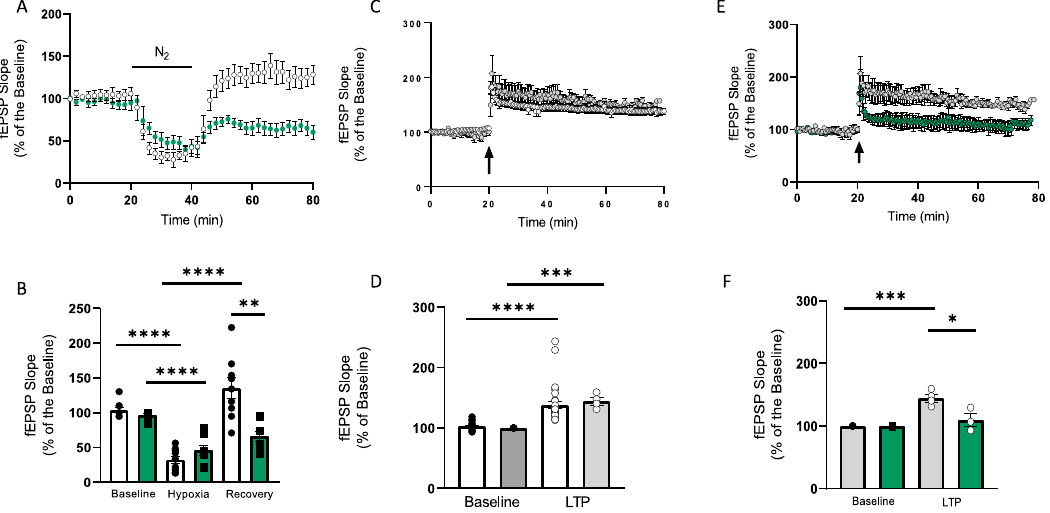
Figure 3. Application of MnTMPyP modulates synaptic transmission and plasticity post-hypoxia. ( A ) Time-course showing changes in CA1 fEPSP slope following a 20 min hypoxic episode for control (white circles) and MnTMPyP (2.5 µM, green circles). In the CA1, hypoxia gave rise to a maximum depression of fEPSP slope to 32.45 ± 6.8% and full recovery (135.41 ± 12%) upon reoxygenation ( n = 9). In slices pretreated with 2.5 µM MnTMPyP, the hypoxia-induced fEPSP slope depression was 45.8 ± 7.4% ( n = 8), with partial recovery upon reoxygenation (66.24 ± 8%; n = 8). ( B ) Bar chart summarising the time-course data in A. White bars represent controls, green bars represent MnTMPyP-treated group. ( C ) Time-course of fEPSP slope before and after HFS from control hippocampal slices (white circles) and from hippocampal slices exposed to 20 min hypoxia (grey circles). Time-course showing control LTP (white circles; n = 27) and LTP post-20 min hypoxia (grey circles; n = 4). HFS induced a stable LTP in control slices lasting 60 min (135.0 ± 6.1%, n = 27) with no di ff erence compared to LTP induced in slices pre-exposed to hypoxia (144.87 ± 5.67%; n = 4). ( D ) Bar charts summarising the data in C. Control (white bars), post-hypoxia (grey bars). Baseline values were taken 5 min before the induction of LTP. LTP fEPSP slope was taken at 60 min post-HFS (white and grey bars). ( E ) In LTP slices pre-treated with hypoxia, HFS was induced 40 min after the 20 min hypoxic episode. Here, the stimulation gave rise to a stable synaptic potentiation lasting for 60 min (144.87 ± 5.67%; n = 4). Application of 2.5 µM MnTMPyP (green circles) signi fi cantly impaired LTP post-hypoxia (113.4 ± 11.9%; n = 4). ( F ) Bar chart summarising the data in E. Control (grey bars), post-hypoxia (green bars). Arrow in C,E indicates timing of HFS. All data are expressed as mean ± SEM. * p < 0.05, ** p < 0.01, ** p < 0.001 **** p < 0.0001.